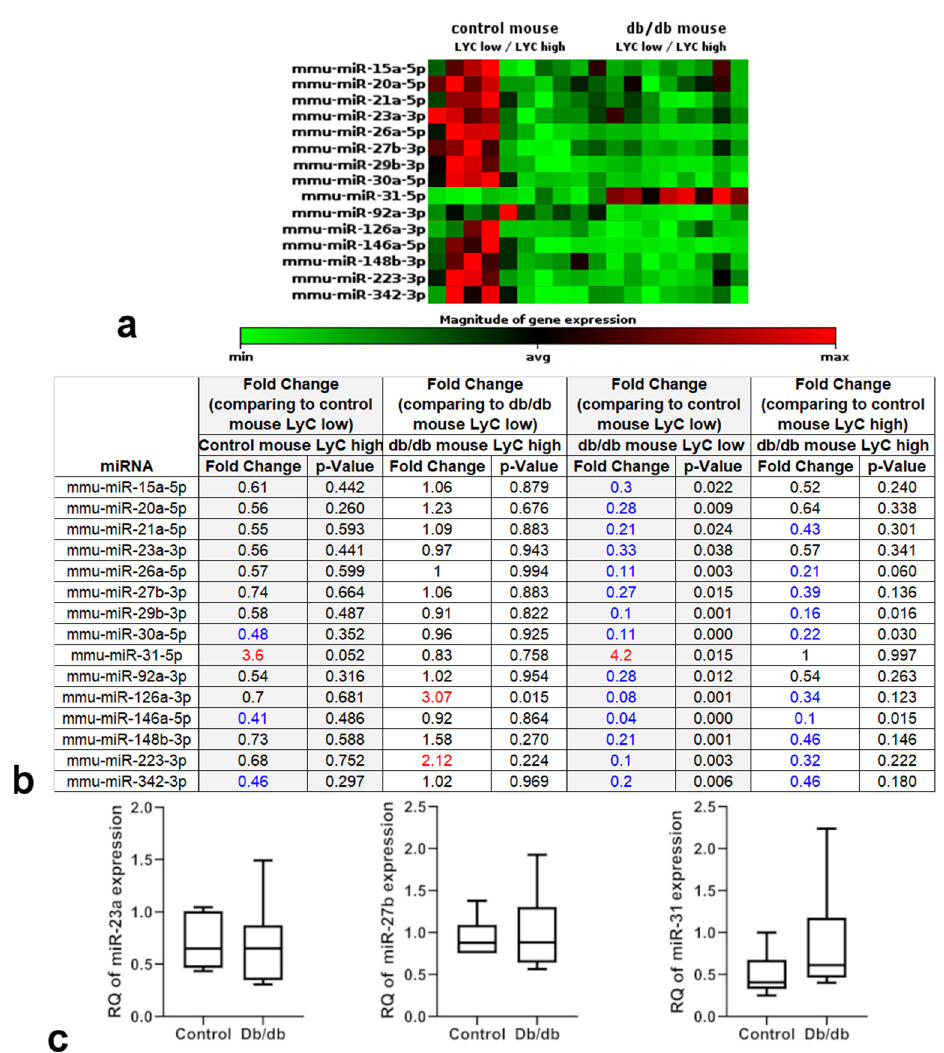
Figure 5. Heat map of selected miRNA expression data ( a ) obtained with NGS from two populations of cardiac macrophages isolated from control ( n = 4) and db/db ( n = 4) mouse hearts. Results were normalized with the “Trimmed Mean of M” method and heat map was prepared based on the geNorm method. Relative miRNA expression is depicted according to the color scale shown below. Red indicates upregulation; green, downregulation. Table ( b ) shows selected miRNAs and fold change, which is the normalized miRNA expression in each Test Sample divided by the normalized miRNA expression in the Control Sample. Numbers in blue indicate downregulation, whereas in red – upregulation of miRNA expression. p -values were calculated with a Bioconductor software package. ( c ) Selected miRNAs expression in cardiac tissue from db/db ( n = 6) and control ( n = 6) mice measured with relative quantitation (RQ) using a comparative C T assay. Cardiac tissue from control mice was used as a calibrator. p -values were calculated with SAS 9.4 software.